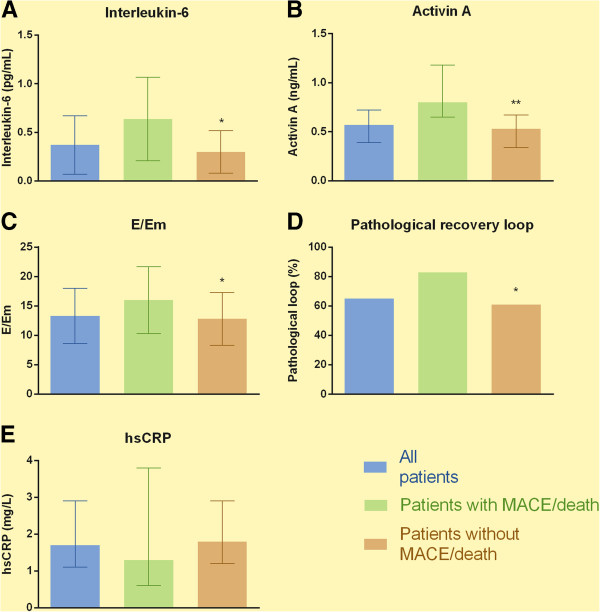
A-E: Novel cardiovascular risk markers stratified by outcome. The columns represent the mean ± SD [IL-6 and E/Em] or median (IQ range) [activin A and hsCRP] levels of novel CV markers, or proportions of participants with pathological loop [pathological loop] in all participants, in those who experienced a MACE or died, and in those who stayed event-free. *: p < 0.05, **: p < 0.01 event vs no event. SD = standard deviation, IL-6 = Interleukin-6, hsCRP = high sensitivity C-reactive protein, CV = cardiovascular, MACE = major adverse cardiovascular event.